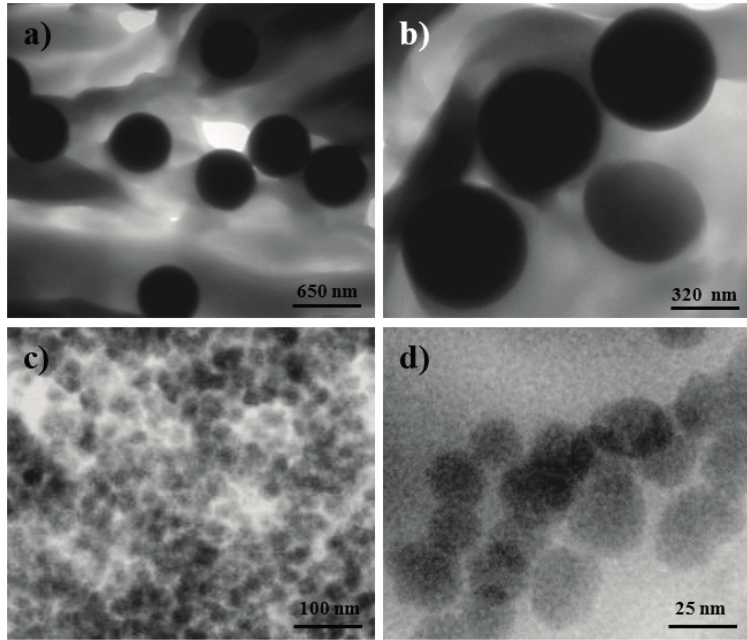
Figure 9. TEM micrographs of the dispersion of functionalized silica microspheres ( a , b )